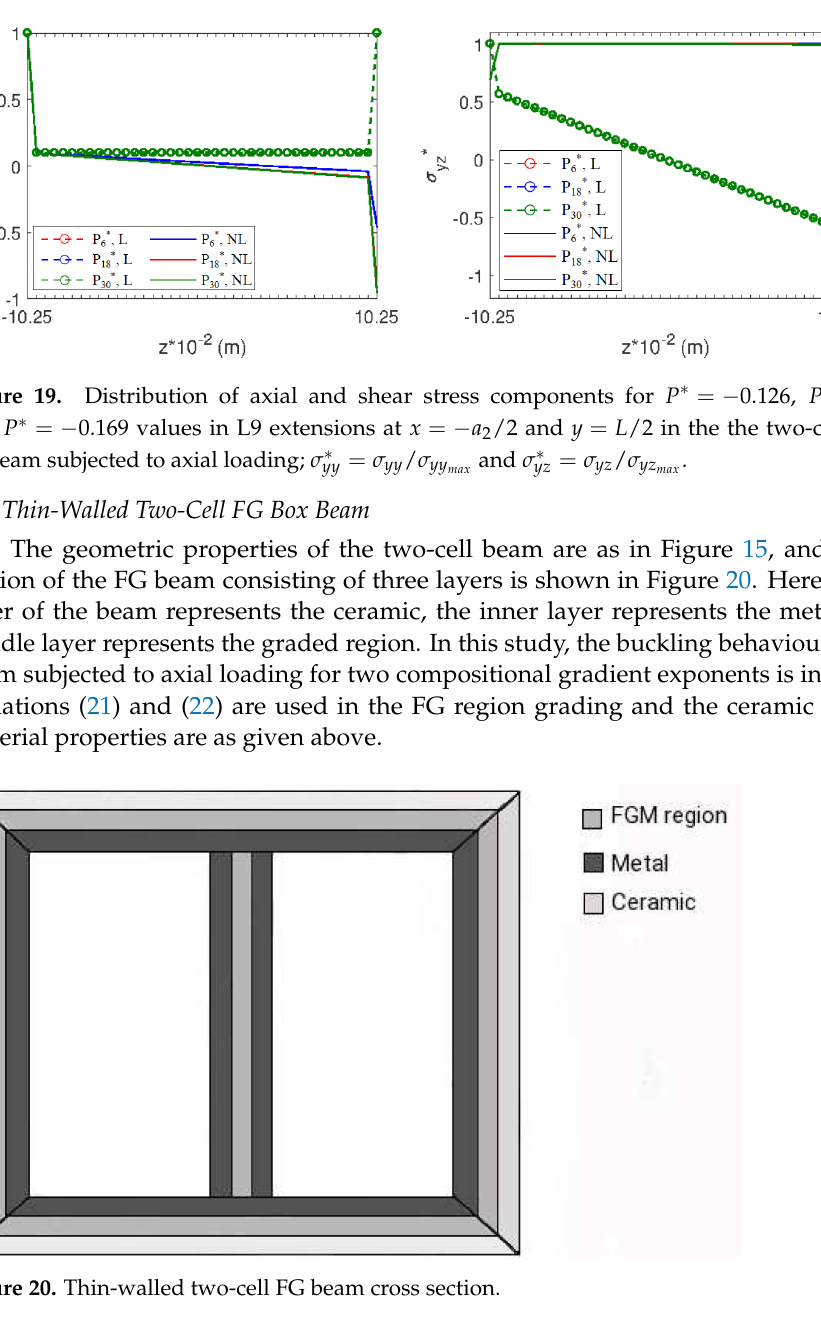
Figure 20. Thin-walled two-cell FG beam cross